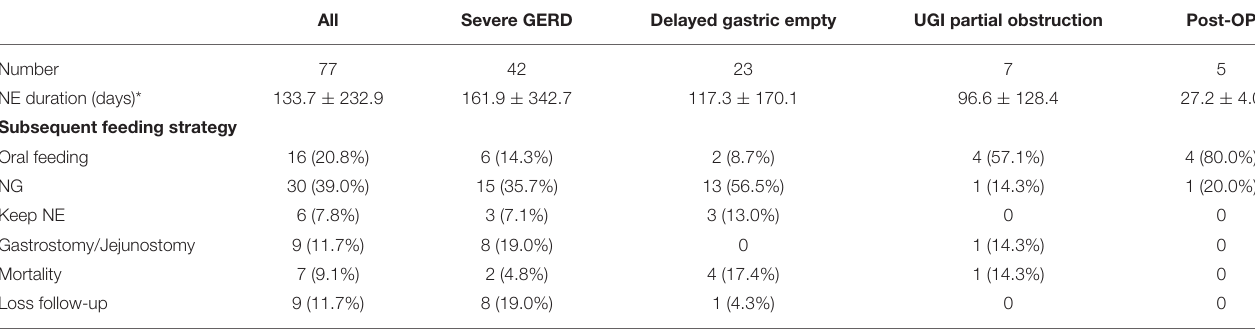
TABLE 2 | Clinical outcomes of NE-tube